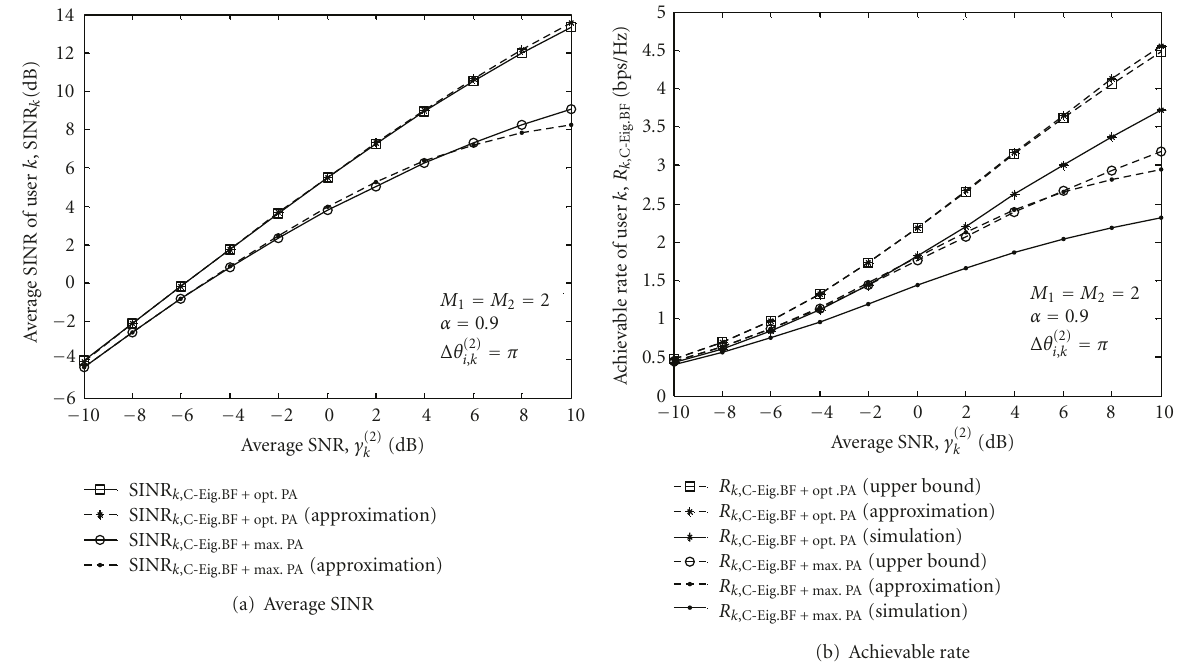
Figure 6: Performance of user k with the proposed scheme according to γ (2)